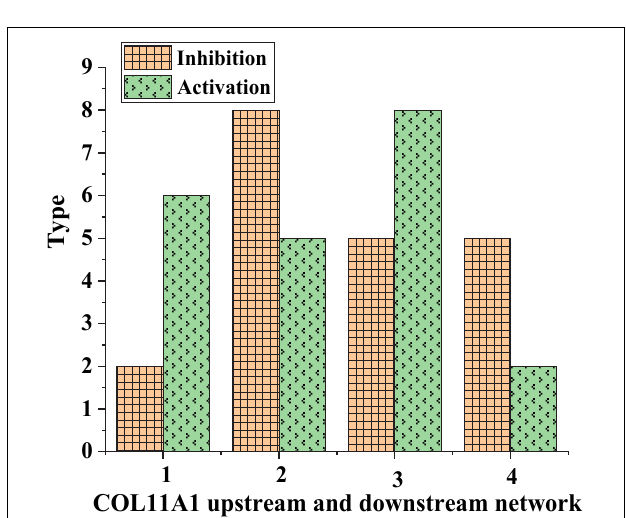
FIGURE 4 | Metastatic molecular types of COL11A1 in different tissues (1 and 3: normal human tissue; 2 and 4: lung cancer tissue).